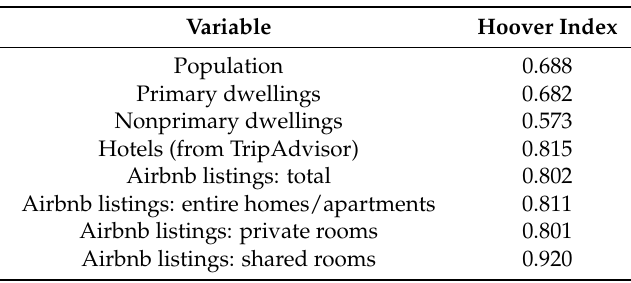
Level of spatial concentration of population, hotels, and Airbnb listings in Spanish municipalities.